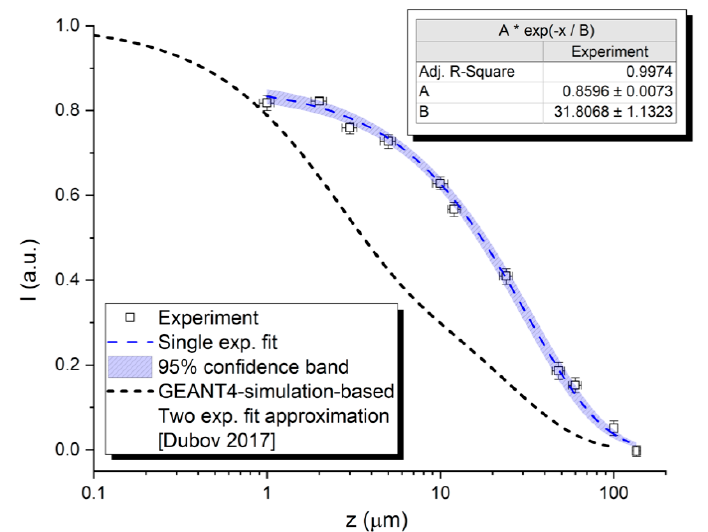
Figure 4. Experimentally obtained positron annihilation depth profile in Fe and the two-exponential approximation obtained from GEANT4 simulation.